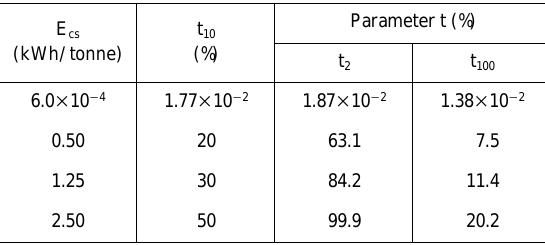
Table 1 Relationship Between E cs and t n